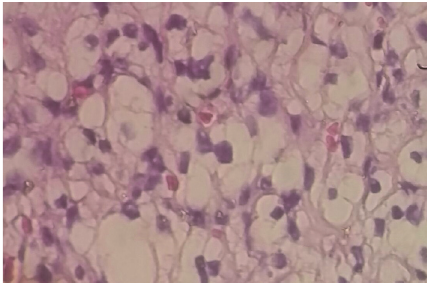
Figure4:Photomicrographat10xshowingclearroundcellswithout